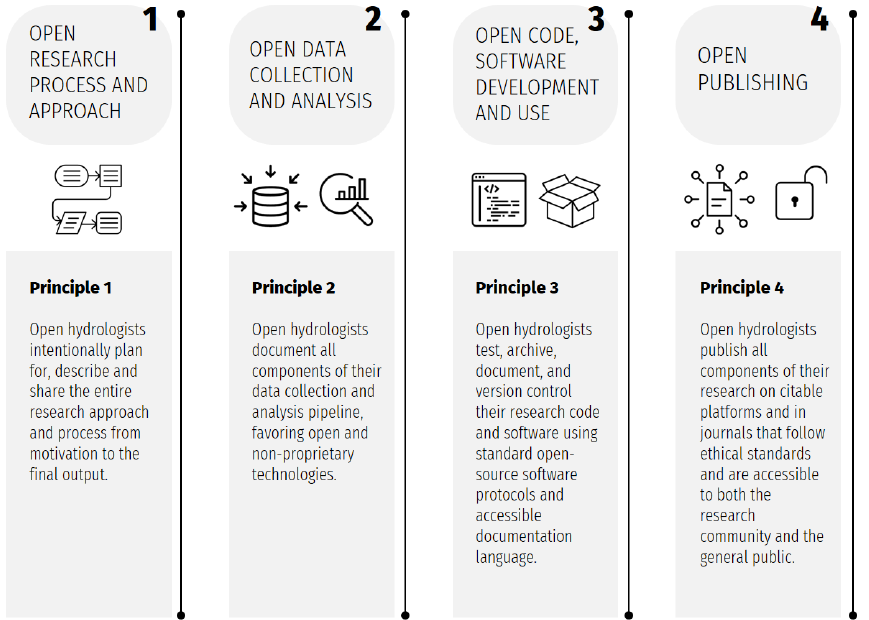
Figure 1. The Open Hydrology